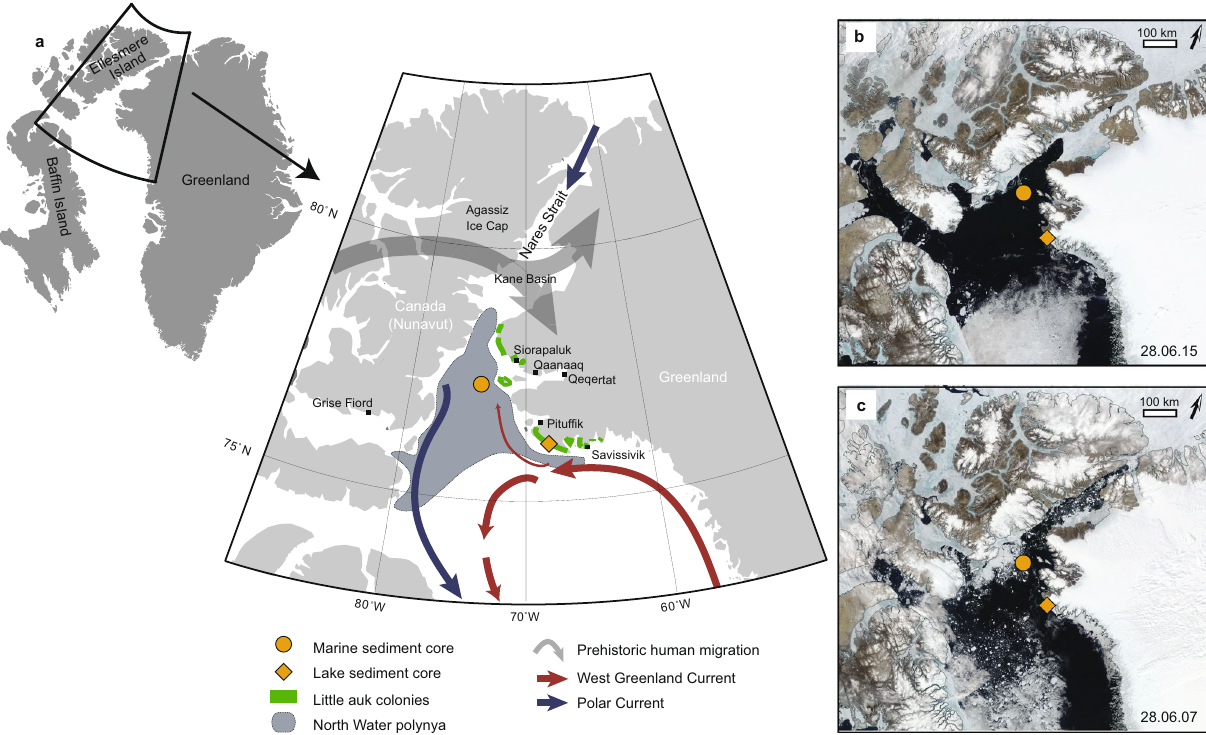
Fig. 1 Location and con fi guration of the North Water polynya. a Marine and lacustrine core sites, main ocean currents, prehistoric human migration routes, and present-day distribution of little auk colonies. The extent of the polynya is de fi ned as in ref. 17 . b Example of late-June polynya con fi guration with a stable ice arch c . Example of late-June con fi guration in the absence of the Kane Basin ice arch. Satellite images from NASA EOSDIS. Several Inuit communities rely directly on the polynya resources today, including Qaanaaq, Siorapaluk, Qeqertat and Savissivik in Northwest Greenland, and Grise Fiord in Nunavut. Background map fi gures were created using Ocean Data View 73